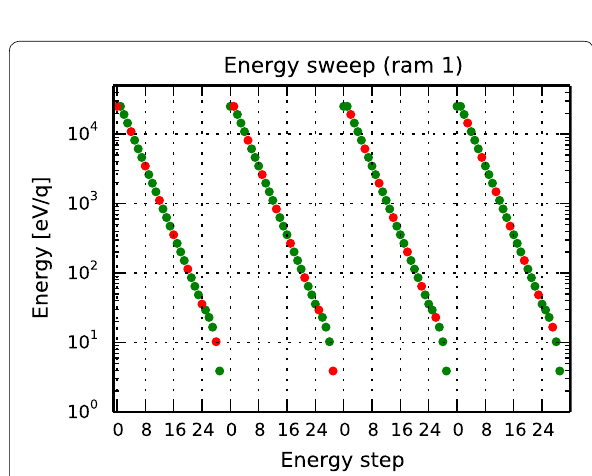
Fig. 14 Selection of energy steps in the TOF mode. Red and green dots show the selected and discarded steps,